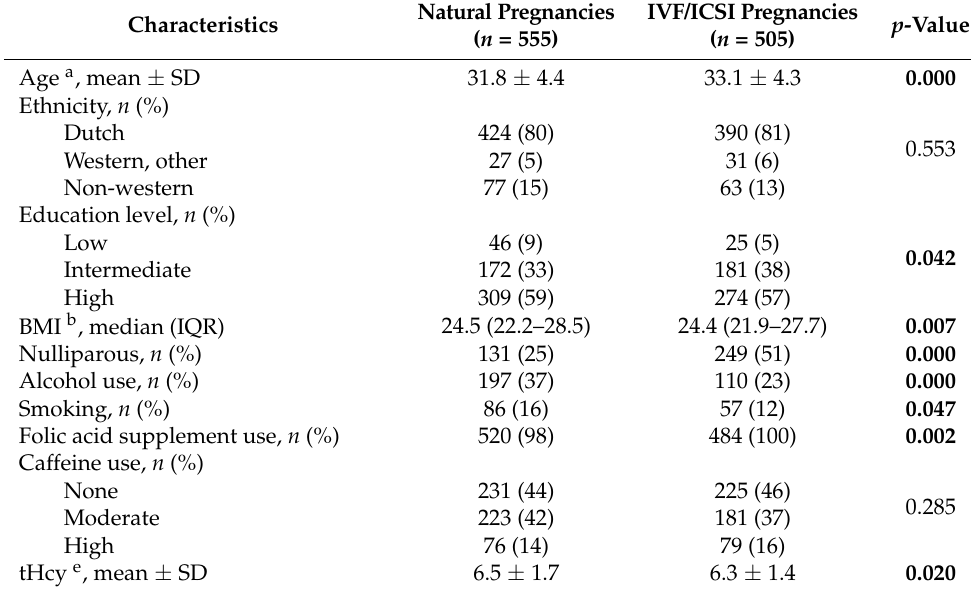
Table 1. Maternal baseline characteristics of natural and IVF/ICSI pregnancies of the included population.